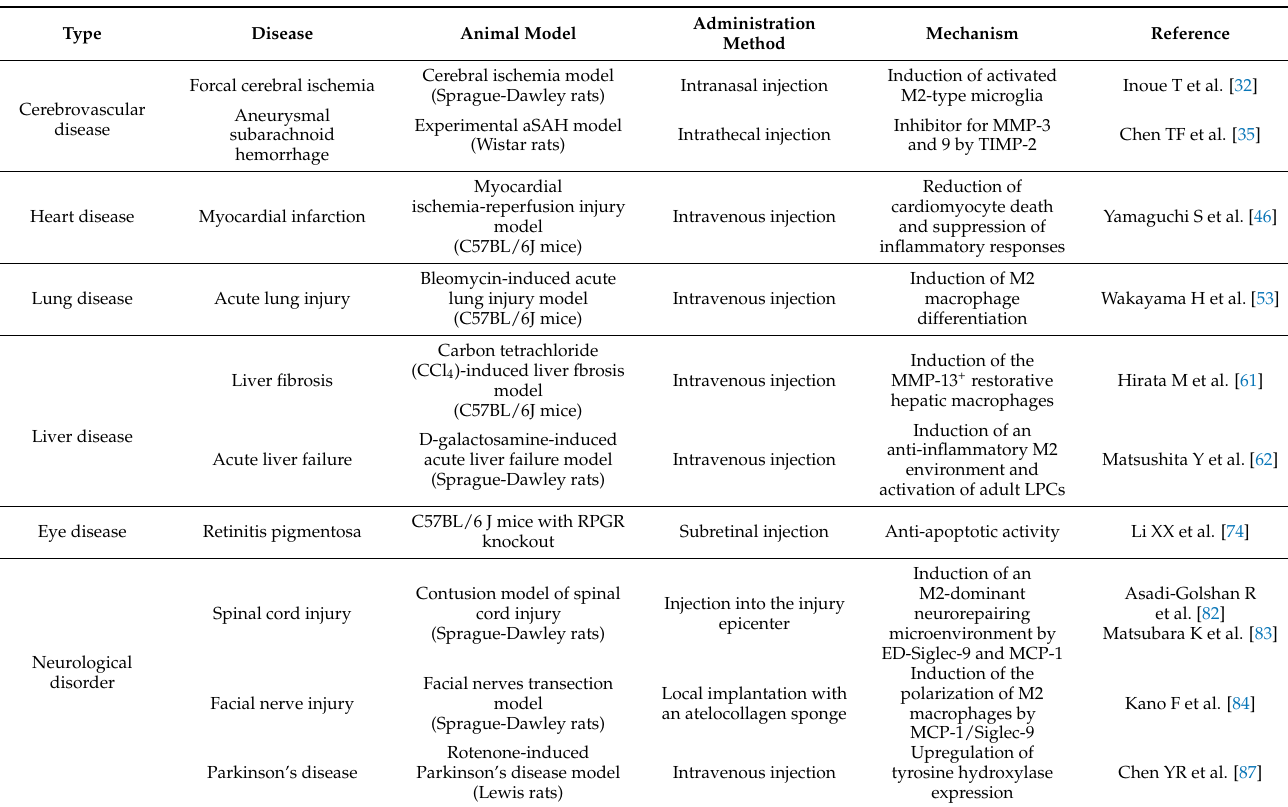
Table 2. Therapeutic effects of DPSC-CM for various